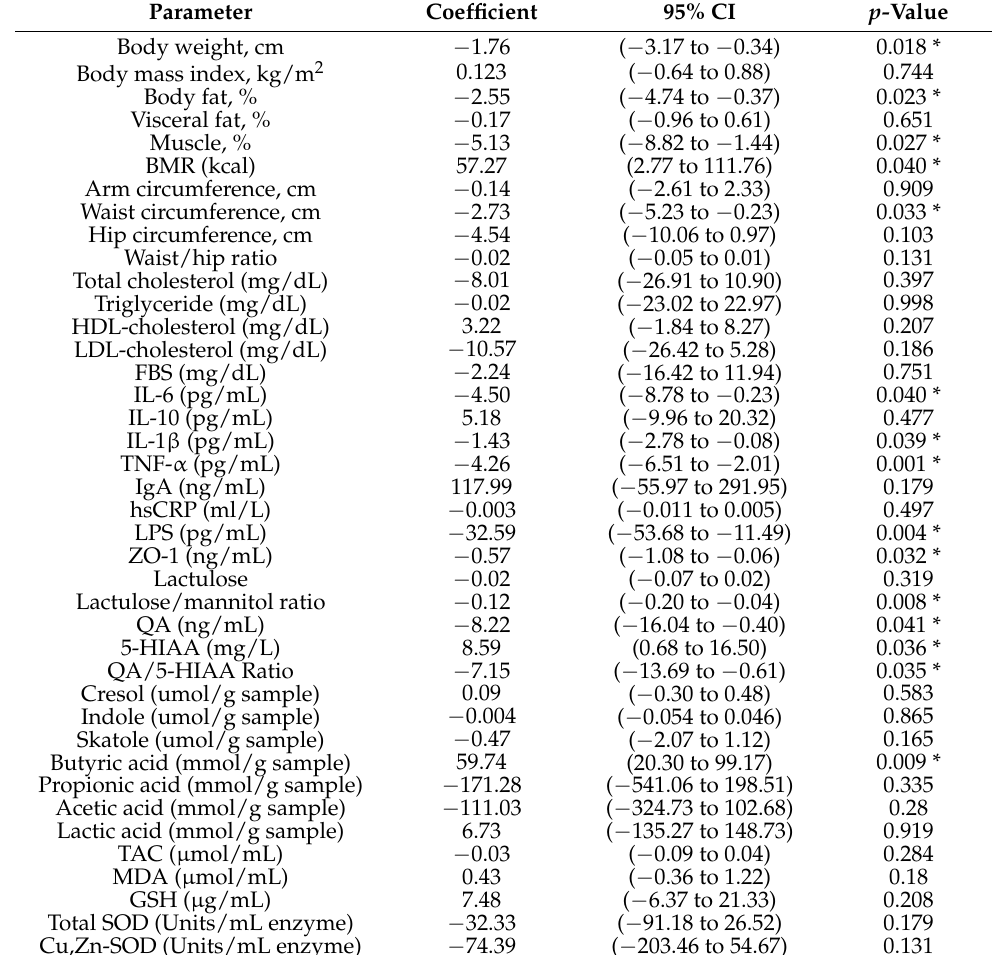
Table 6. Gaussian regression analysis summary at week 12 of supplementation for synbiotic